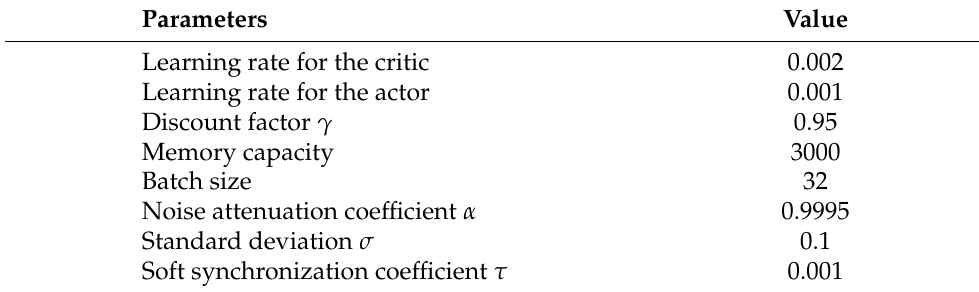
Table 4. Training hyperparameter